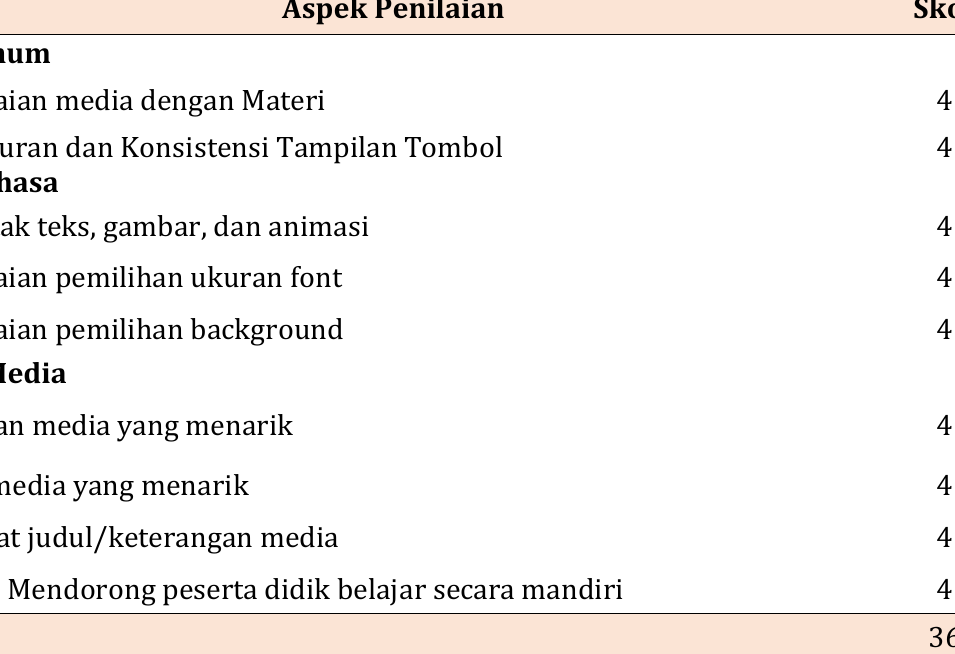
Table 4. Result of Media Validation